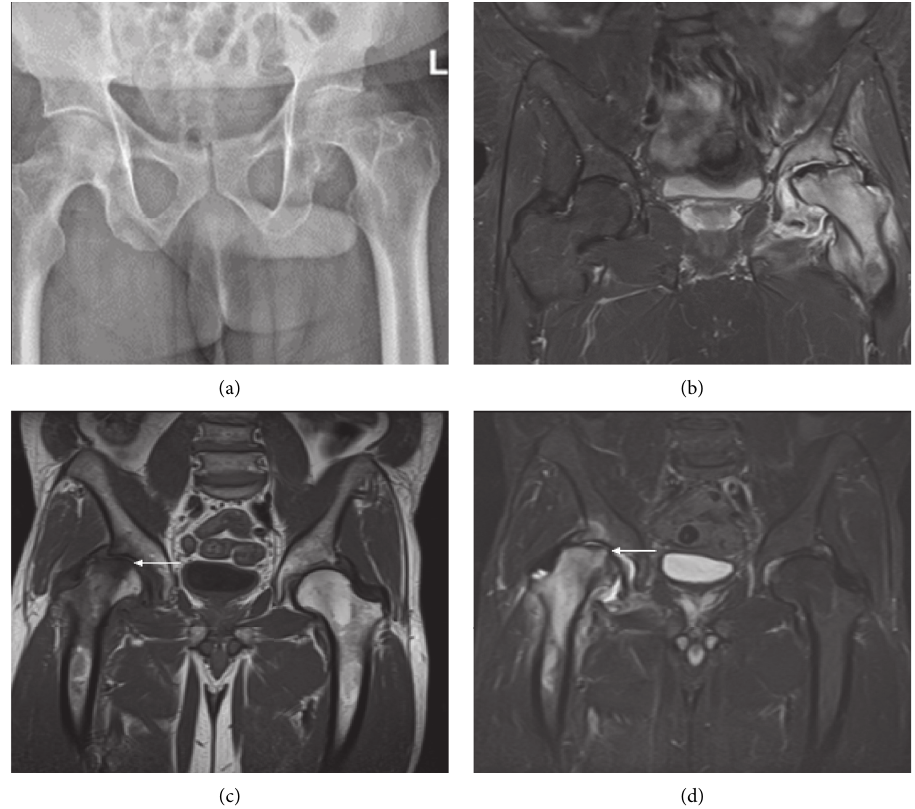
Figure 8: Two cases of rapidly progressive hip osteoarthritis. X-ray (a) and coronal STIR (b) of a 78-year-old man presenting with an increasingly painful and stiff left hip, demonstrating left hip joint effusion, joint marrow oedema signal, and flattening of the femoral head. Joint aspirate and subsequent washout were negative for infection. Coronal T1 (c) of a second patient with coronal STIR (d) performed 2 months apart shows the rapidly progressive nature of this condition, with hatchet-like deformity of the femoral head in the latter study (d arrow) due to subchondral insufficiency